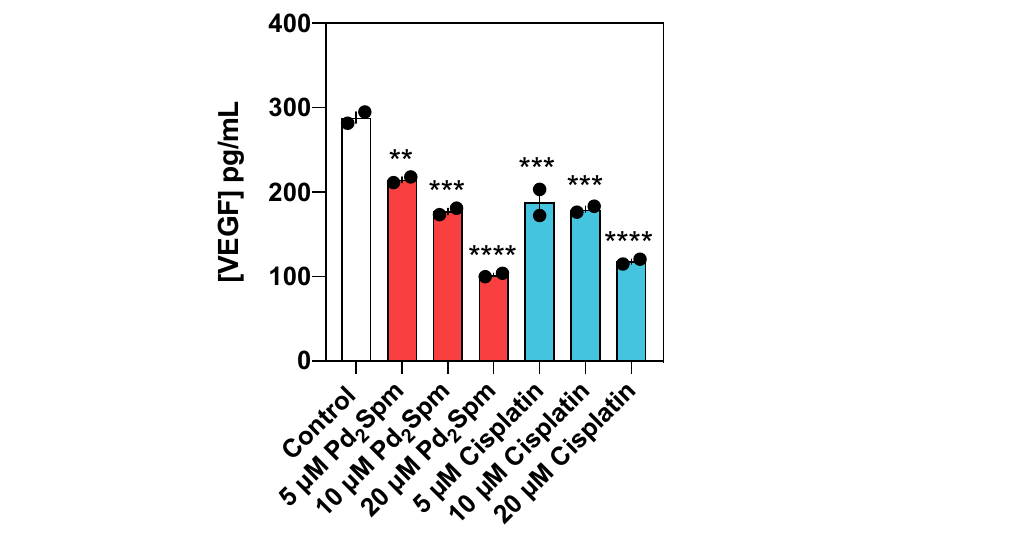
Figure 8. Quantitative results of VEGF secretion by MDA-MB-231 incubated for 12 h with Pd 2 Spm (red) or cisplatin (blue). Data are shown as means ± SEM ( n = 2) and analyzed with one-way ANOVA followed by Dunnett’s multiple comparison test. Significant differences from the control: ** p < 0.01, *** p < 0.001, **** p < 0.0001.